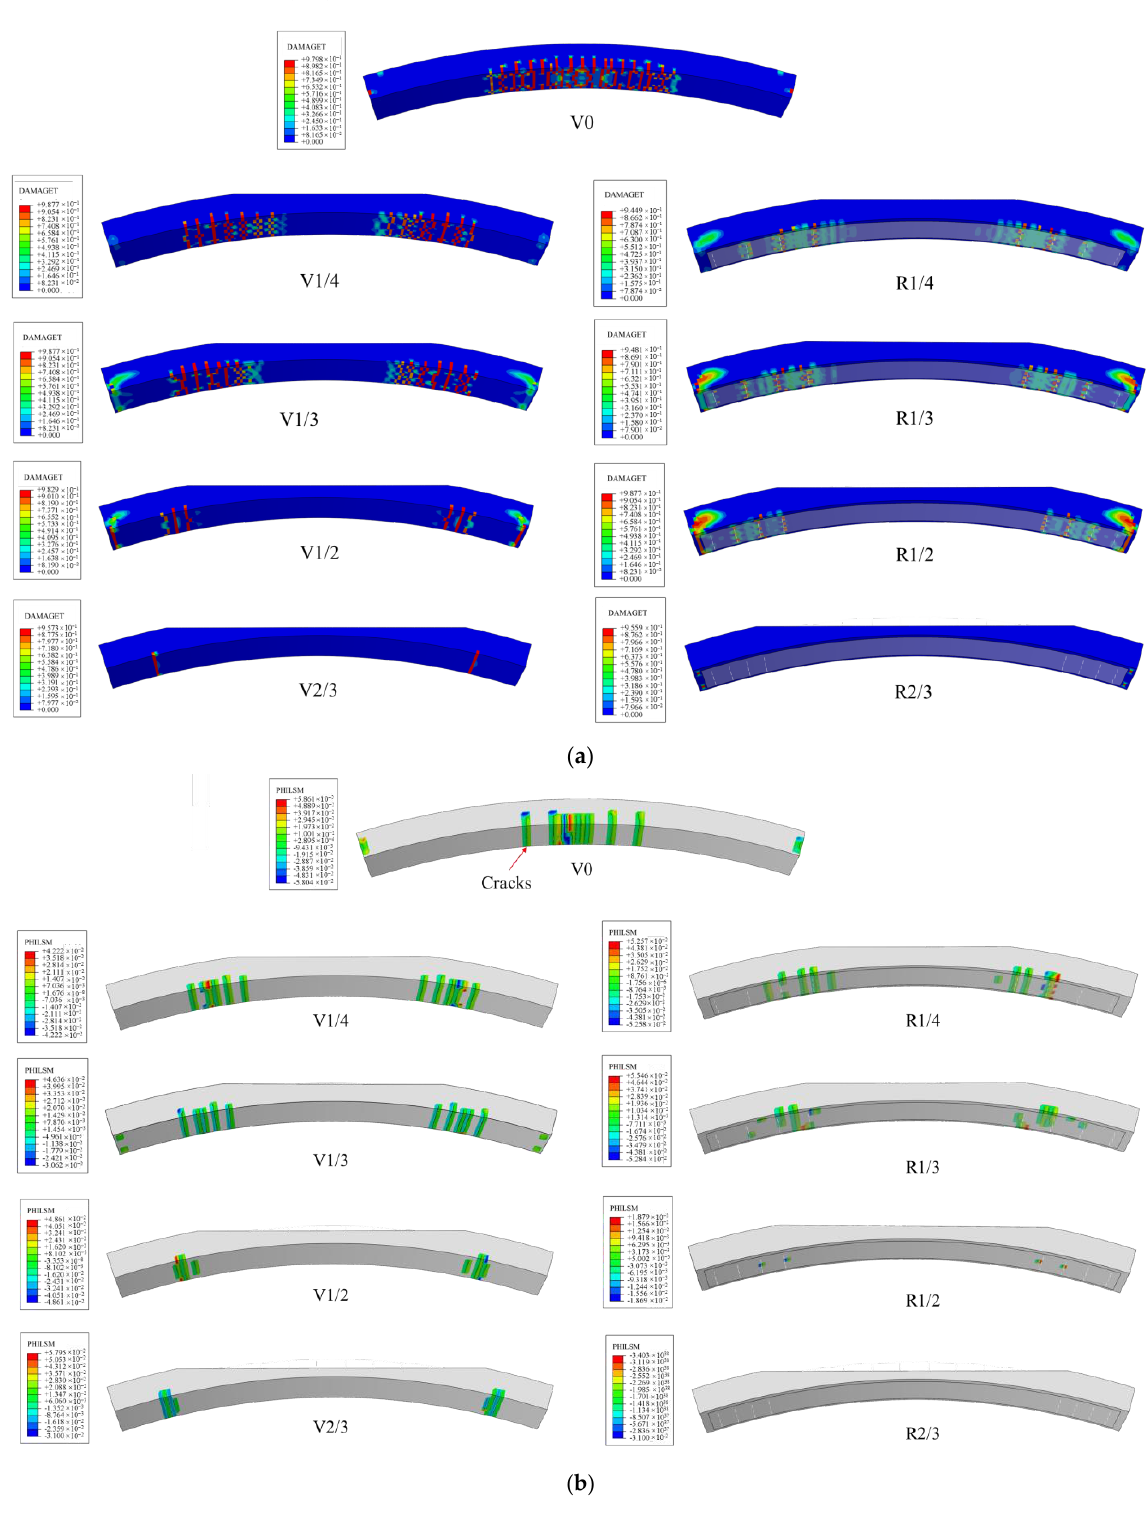
Figure 15. Damage pattern and crack propagation of specimens: ( a ) CDP and ( b ) XFEM.